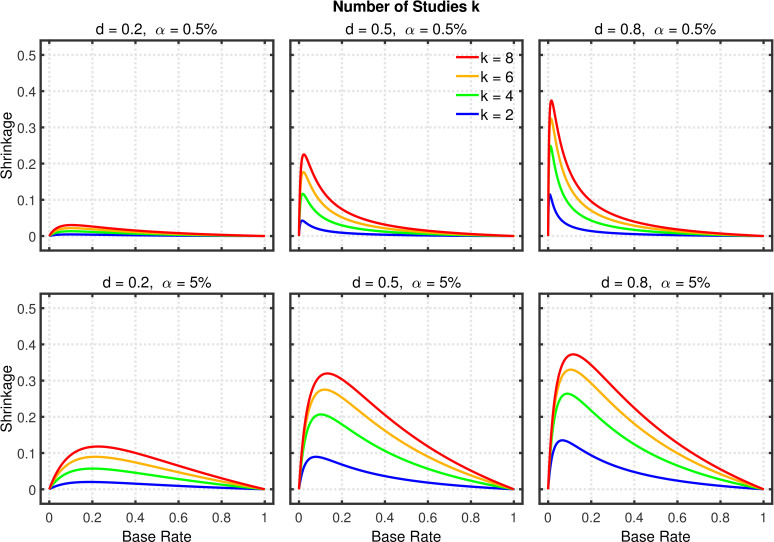
Selective reporting of significant studies.Shrinkage of the replication rate (i.e., the difference between the solid line and the dashed line in Figure 5—figure supplement 2) as a function of base rate π, number of studies k, effect size d, and nominal α level (0.5% or 5%).